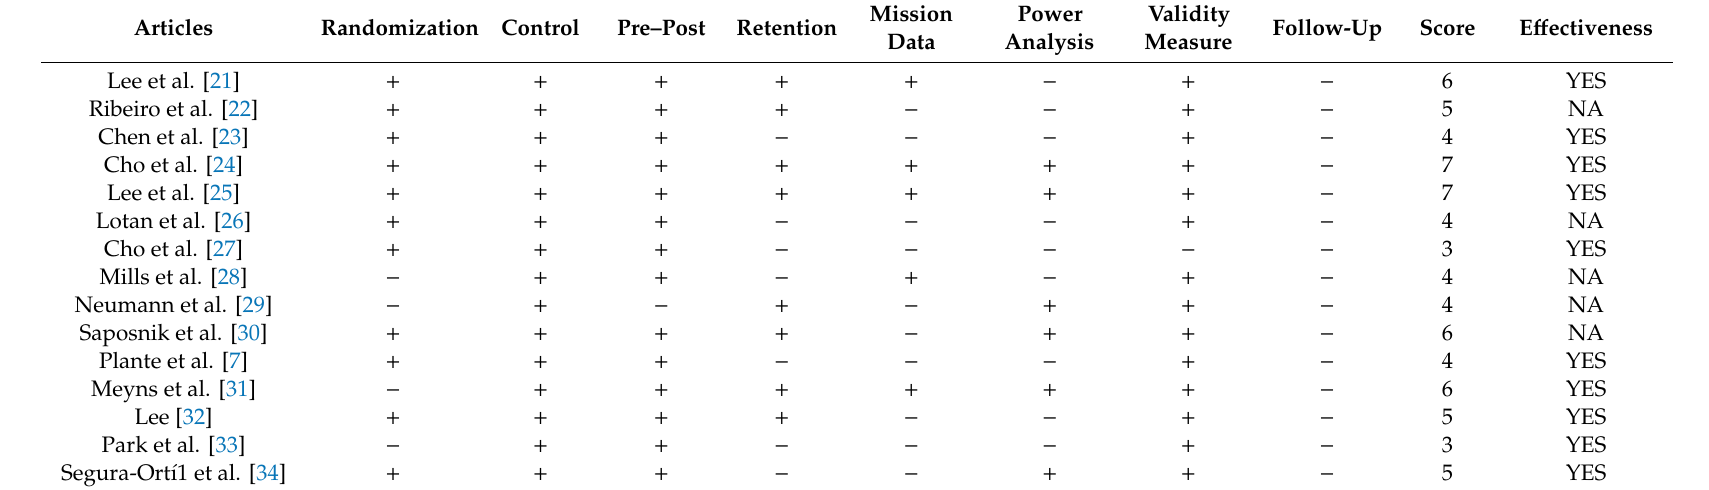
Table 1. Design quality